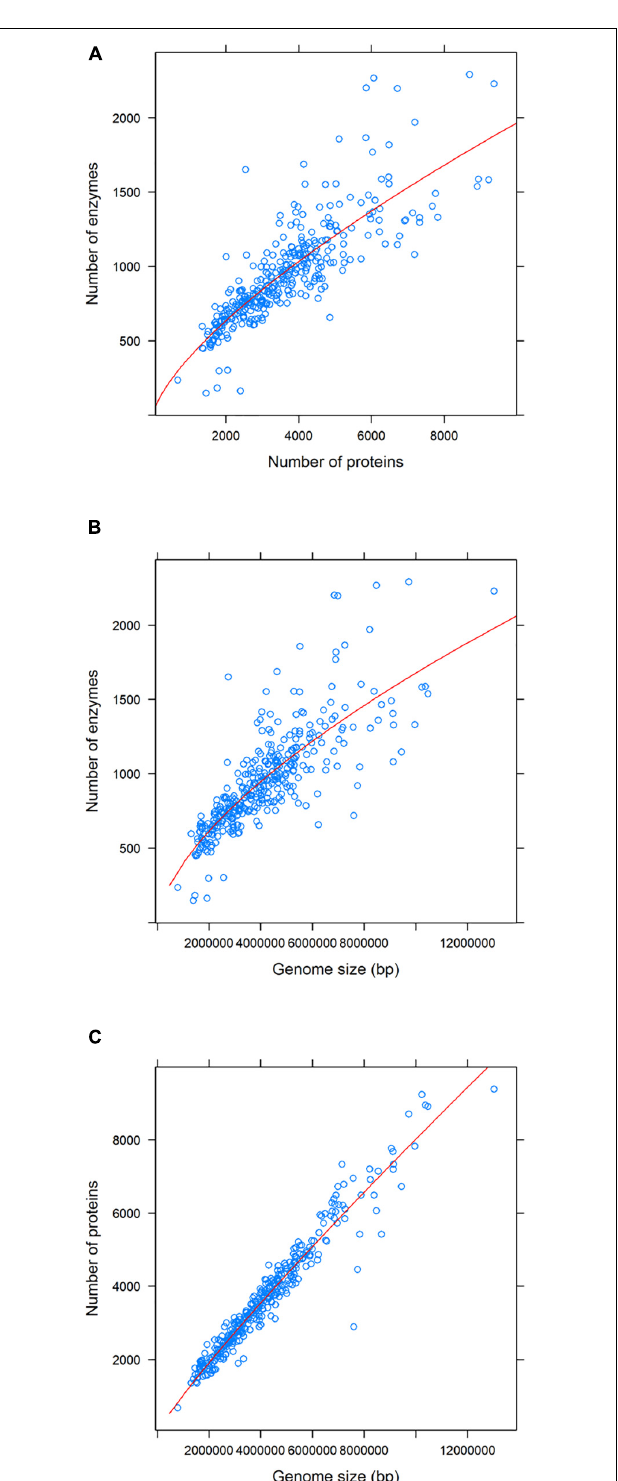
FIGURE 1 | Relation between the enzyme and protein content, and the genome size. For each pair of variables, a power-law equation is the one that best explains the distribution of the data. The equations and R -squared values are as follows: (A) y = 2.51 x 0 . 72 ; R 2 = 0.79, (B) y = 0.04 x 0 . 66 ; R 2 = 0.76; (C) y = 0.004 x 0 . 9 ; R 2 = 0.95.